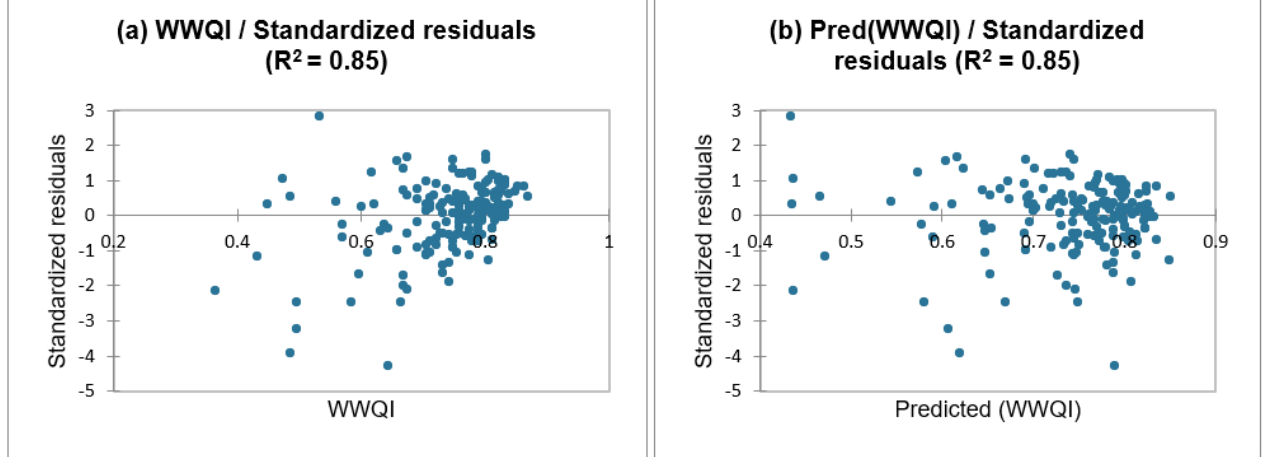
Figure 5. The plot of residuals versus ( a ) WWQI and ( b ) Predicted WWQI by XLSTAT model. Analysis of variance (ANOVA) results of the regression coefficients, the sum of squares, and p -values were determined. Multiple linear regression analysis was per- formed to evaluate the statistically significant variables at a significant level of 0.05. The concentrations of variables are expressed in mg/L. The linear regression equation obtained